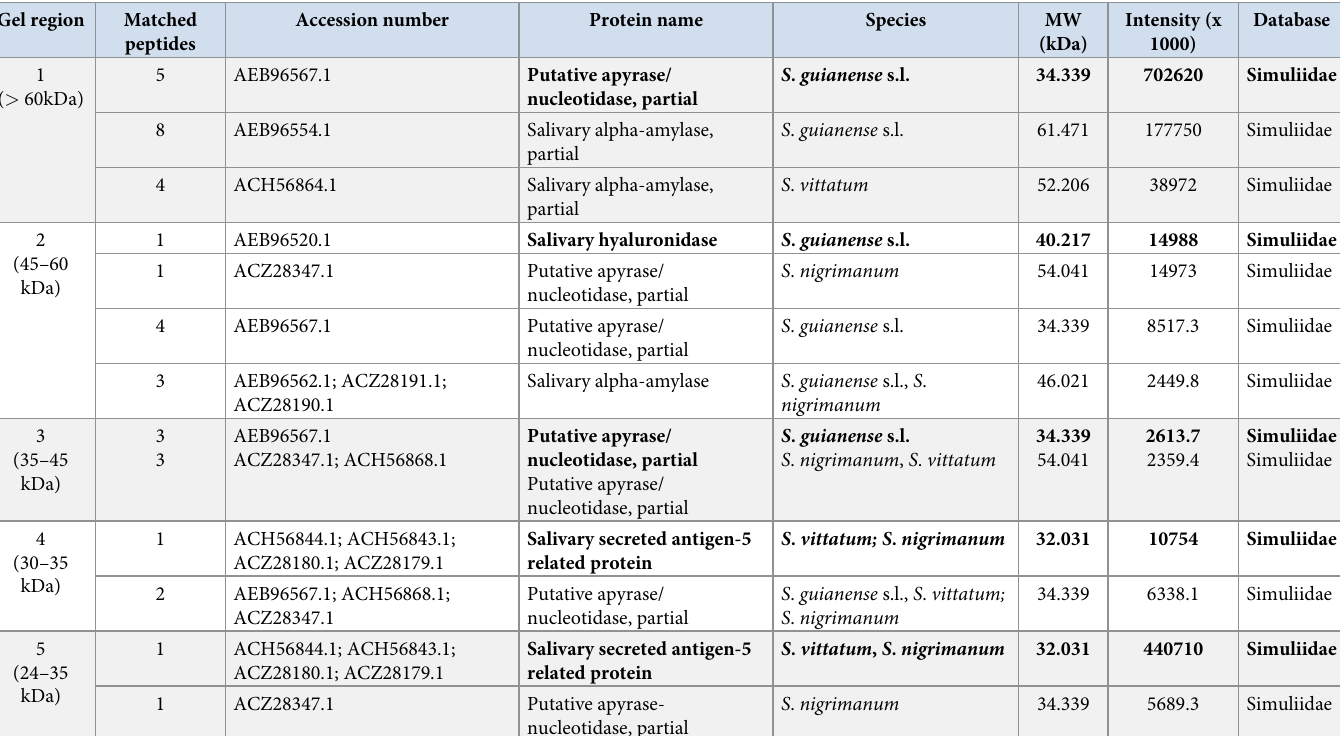
Table 1. Proteome analysis of S . damnosum s.l. salivary proteins. Protein bands of interest were cut from a Coomassie G-250-stained SDS-PAGE gel and analyzed by liquid chromatography-tandem mass spectrometry (LC-MS/MS). The obtained data were screened against available cDNA libraries of Simuliidae, Culicoides nubeculosus , and Culicoides sonorensis . The identified proteins per gel region are listed according to their intensity with their GenBank accession number, the name of the protein, the species, and its molecular weight. Identified proteins highlighted in bold are the most intensely present per gel region. Gel